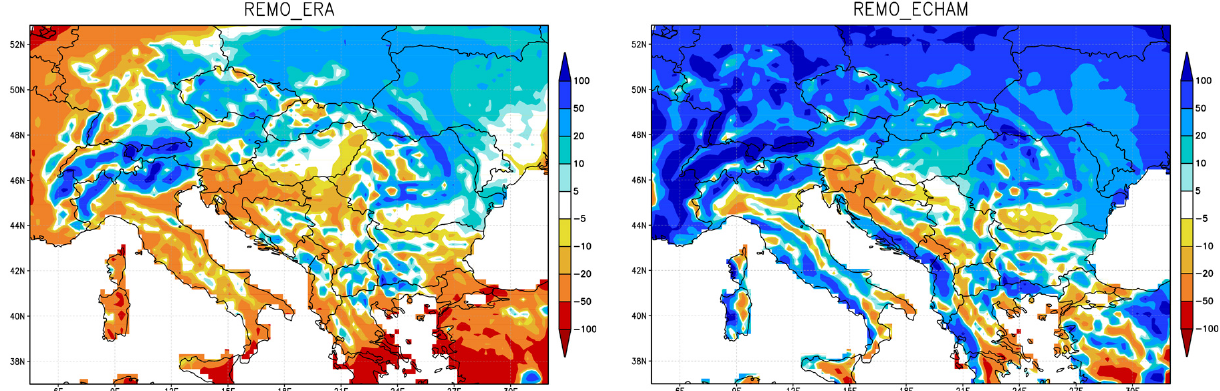
Figure 4. Relative annual precipitation di ff erence [%] between the REMO simulations (ERA40-driven REMO on the left, ECHAM-driven REMO on the right) and the CRU1.2 observations for